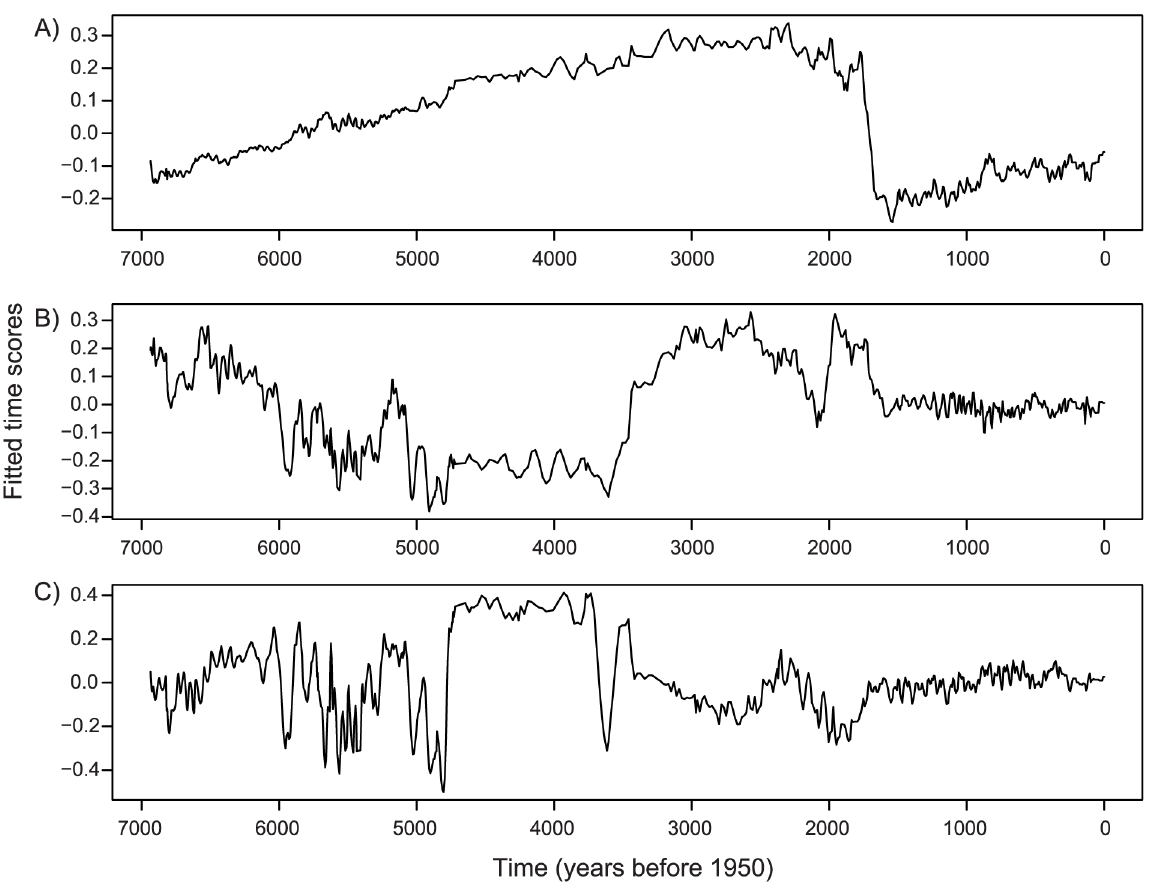
Figure 4. The first three significant axes of the multivariate time-series modeling. The proportion of variance explained by each axis is 29%, 18%, and 8% respectively. The amplitude of the frequency is low in axis one ( A ) with a major shift in score at , 1.7 ka, indicating a regime shift to an alternate state. This regime shift occurred when the lake changed from a shallow lake dominated by benthic taxa to a deep lake dominated by planktic taxa. Frequency pattern changes are present in axes two ( B ) and three ( C ) at , 4.8–5 ka and , 2–1.3 ka, at the beginning and the end of the period of instability.